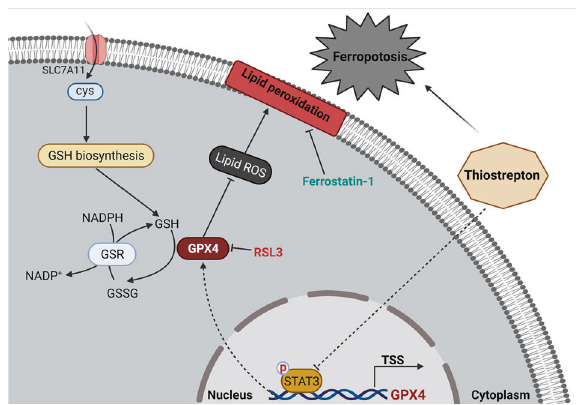
Fig. 7 Schematic diagram of the proposed mechanism by which thiostrepton modulates ferroptosis via the STAT3/GPX4 signalling pathway. In general, in pancreatic cancer cells, TST does not regulate the function of SLC711A but instead alters the expression of STAT3. Activated STAT3 binds to the GPX4 promoter region to promote its transcription. Therefore, GPX4 downregulation by